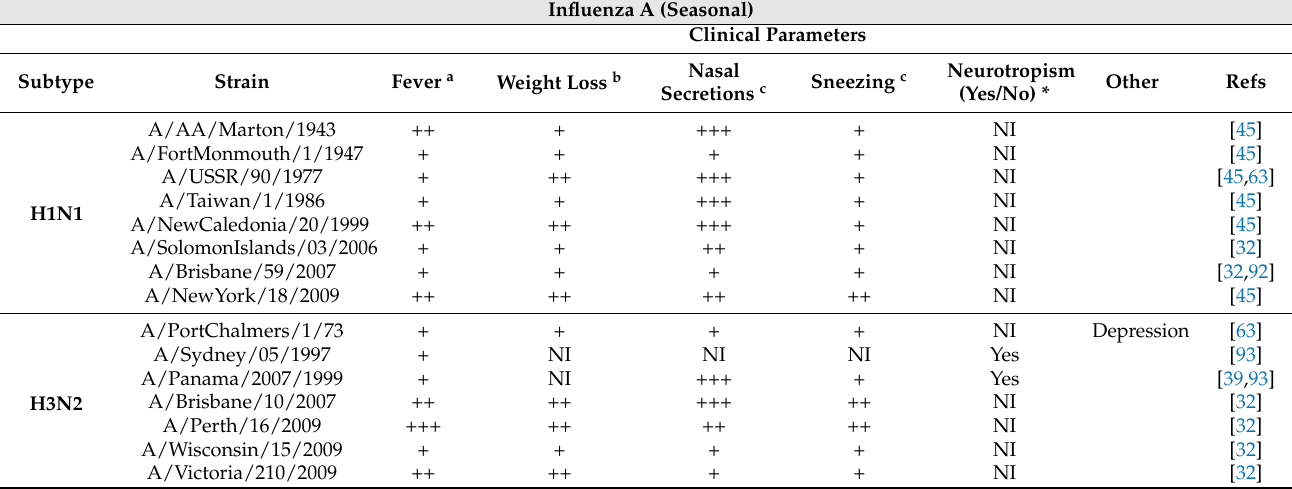
Table 2. Infection with influenza virus types A and B show variable, strain-dependent clinical pictures in ferrets. Influenza A (Seasonal) Clinical